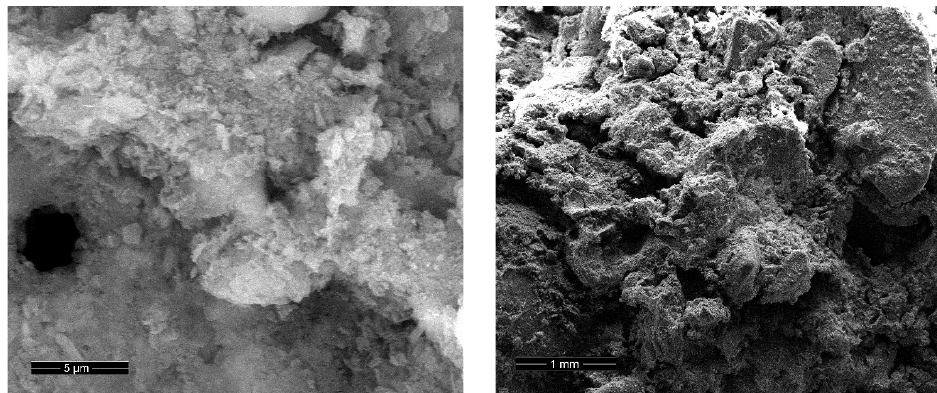
Figure 7. Scanning electron microscopy images for sample B.